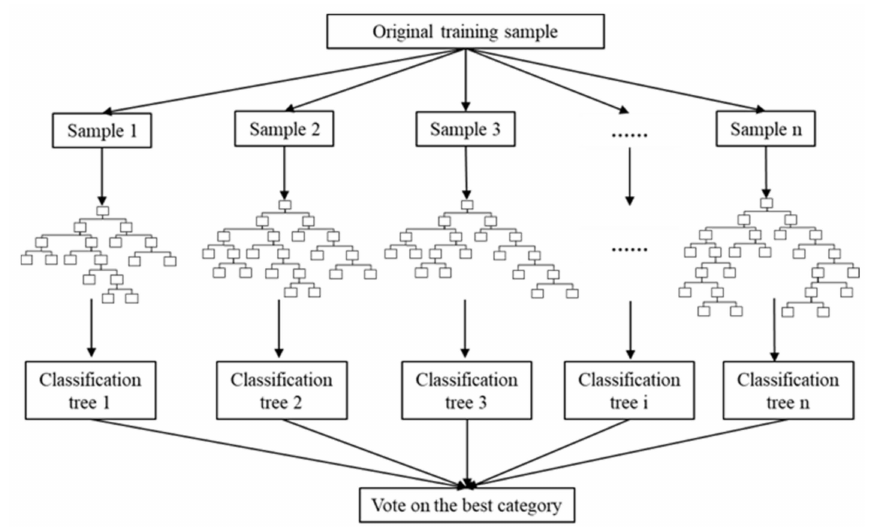
Figure 5. Schematic diagram of random forest